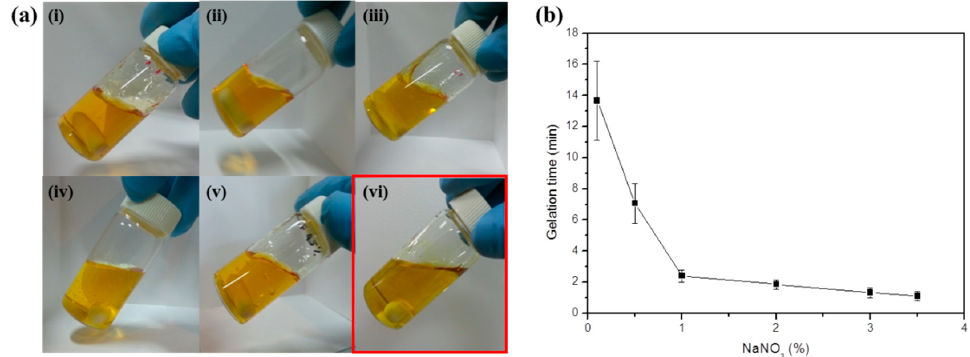
Figure 3. ( a ) Effect of NaNO 3 concentration on gelation: ( i ) 0.1% NaNO 3 ; ( ii ) 0.5% NaNO 3 ; ( iii ) 1% NaNO 3 ; ( iv ) 3% NaNO 3 ; ( v ) 3.5% NaNO 3 and ( vi ) 4% NaNO 3 ; ( b ) Gelation time of SF solution according to NaNO 3 concentration. The red part indicates a non-gelated SF solution at a 4% NaNO 3 concentration.